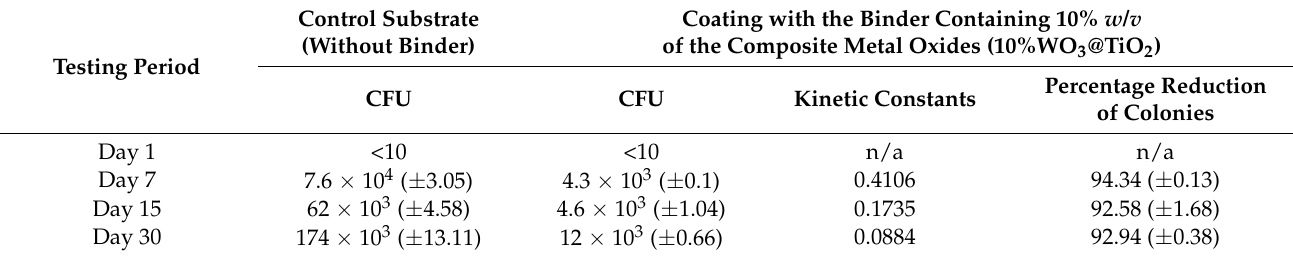
Table 5. Antibacterial performance of various substrates tested under seawater.